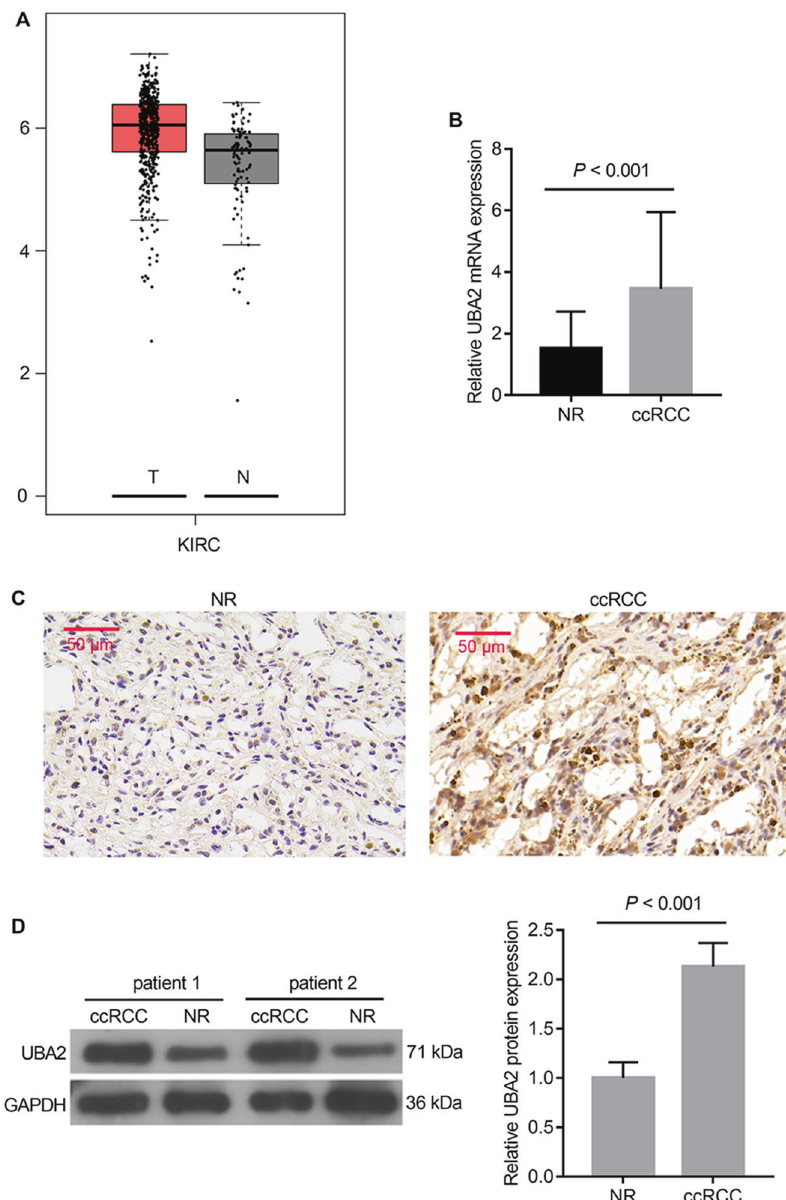
Fig. 1 UBA2 levels in ccRCC tissues. A UBA2 mRNA expression levels in the Gene Expression Pro fi ling Interactive Analysis database. The red bar indicates kidney renal clear cell carcinoma (KIRC) tumor tissue ( T , n = 523), and the gray bar indicates normal kidney tissue ( N , n = 100). ( B ) UBA2 mRNA expression levels in 30 pairs of ccRCC and adjacent NR tissues from patients. C Immunohistochemical staining of ccRCC and adjacent NR tissues for UBA2 (100×). D Western blot analysis of UBA2 levels in ccRCC and adjacent NR tissues. ccRCC clear cell renal cell carcinoma, NR normal renal